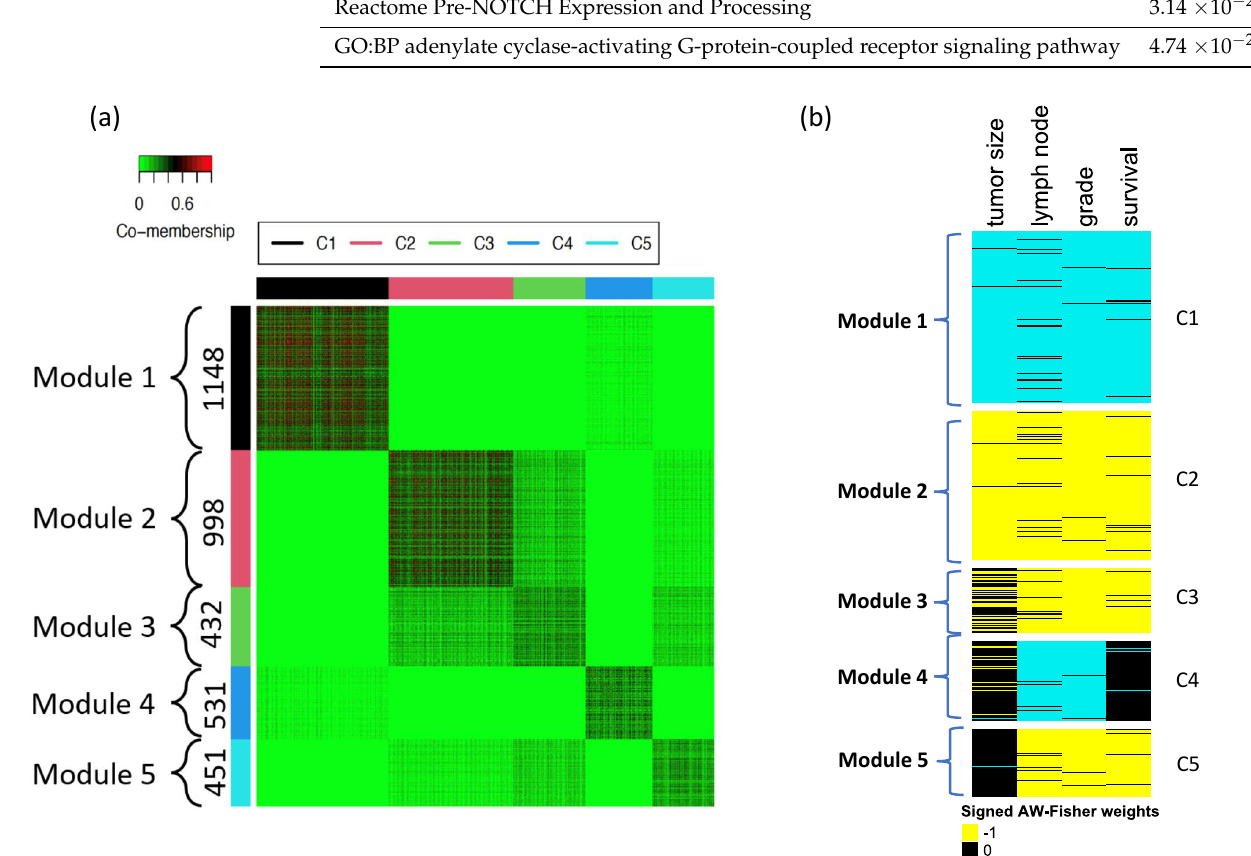
Figure 2. ( a ) The heatmap of the co-membership matrix of five clusters identified in the breast cancer (METABRIC) dataset. Red color means two genes are close. The number in the parentheses indicates the sample size of each cluster. ( b ) The weight estimation of each gene (blue represent 1, black represents 0, and yellow represents −